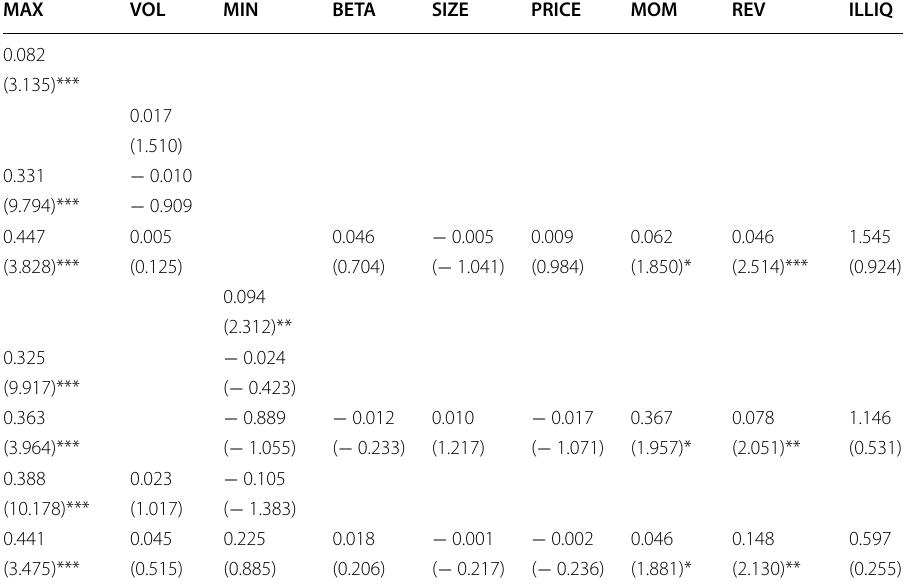
Table 11 Cross-sectional return regressions with MAX, MIN and